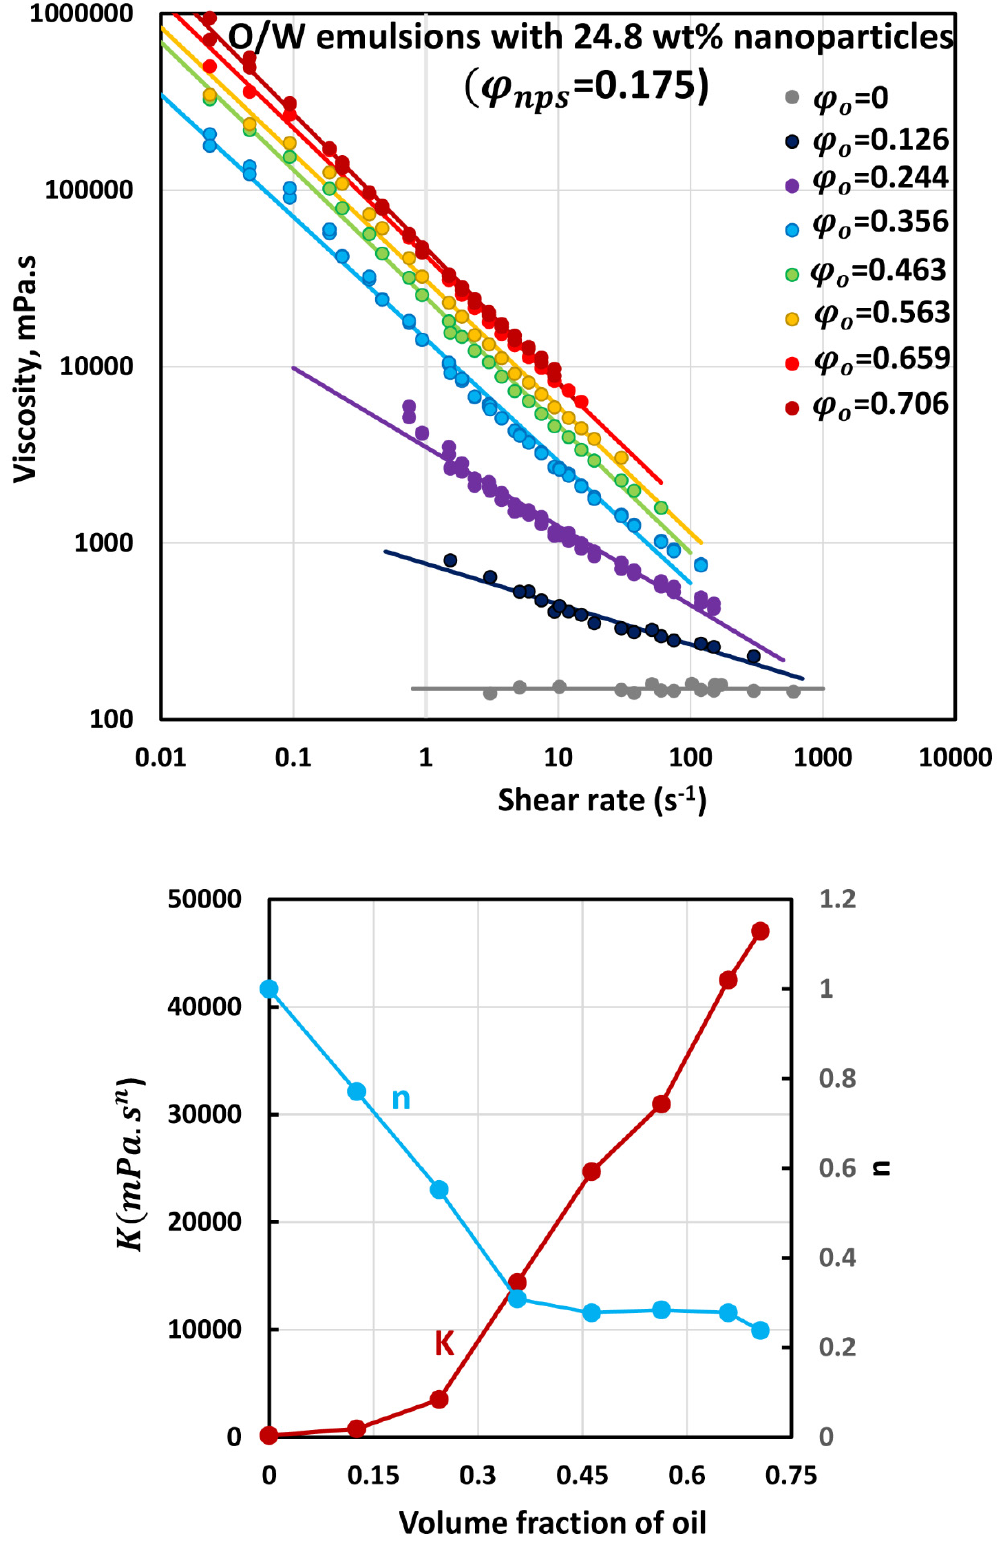
Figure 10. Flow behavior of O/W emulsions thickened with starch nanoparticles at nanoparticle concentration of 24.8 wt% ( ϕ nps = 0.175).